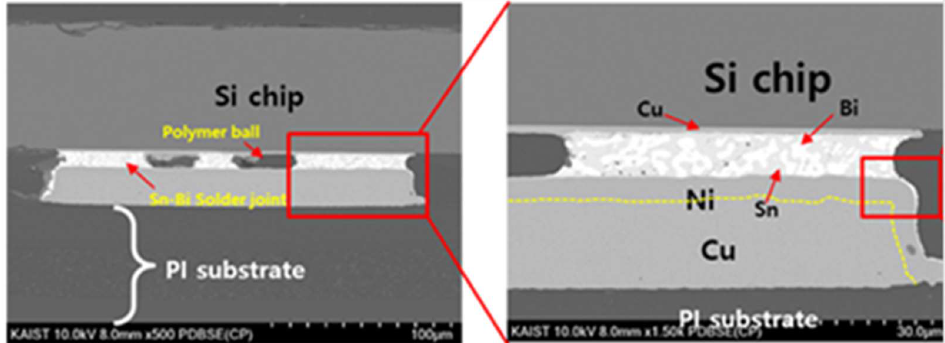
Figure 11. Cross-sectional image of the flexible package.